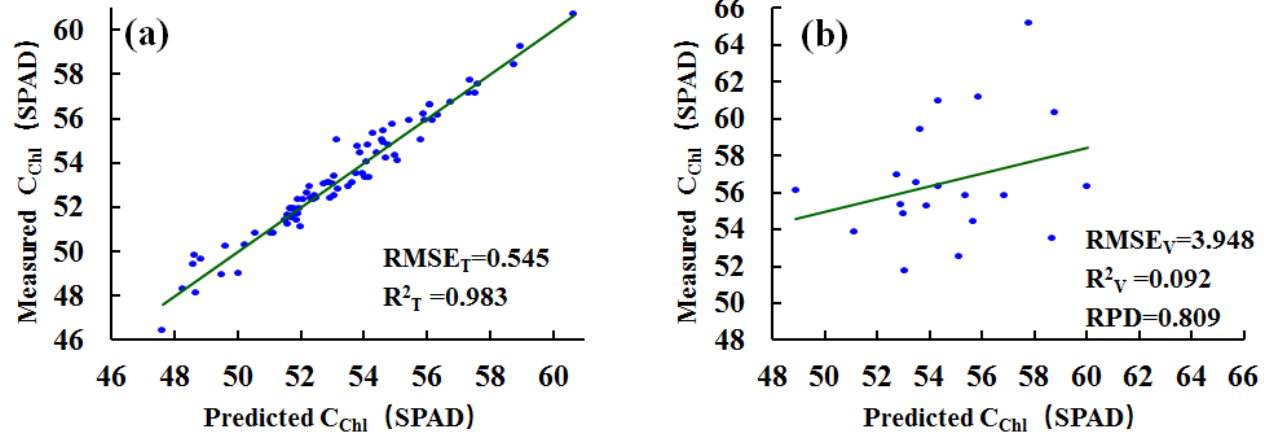
Figure 12. The estimated results of SPAD value for ( a ) training set and ( b ) validation set based on pretreatment WPD-(1/R)’-PCADR at flowering stage.